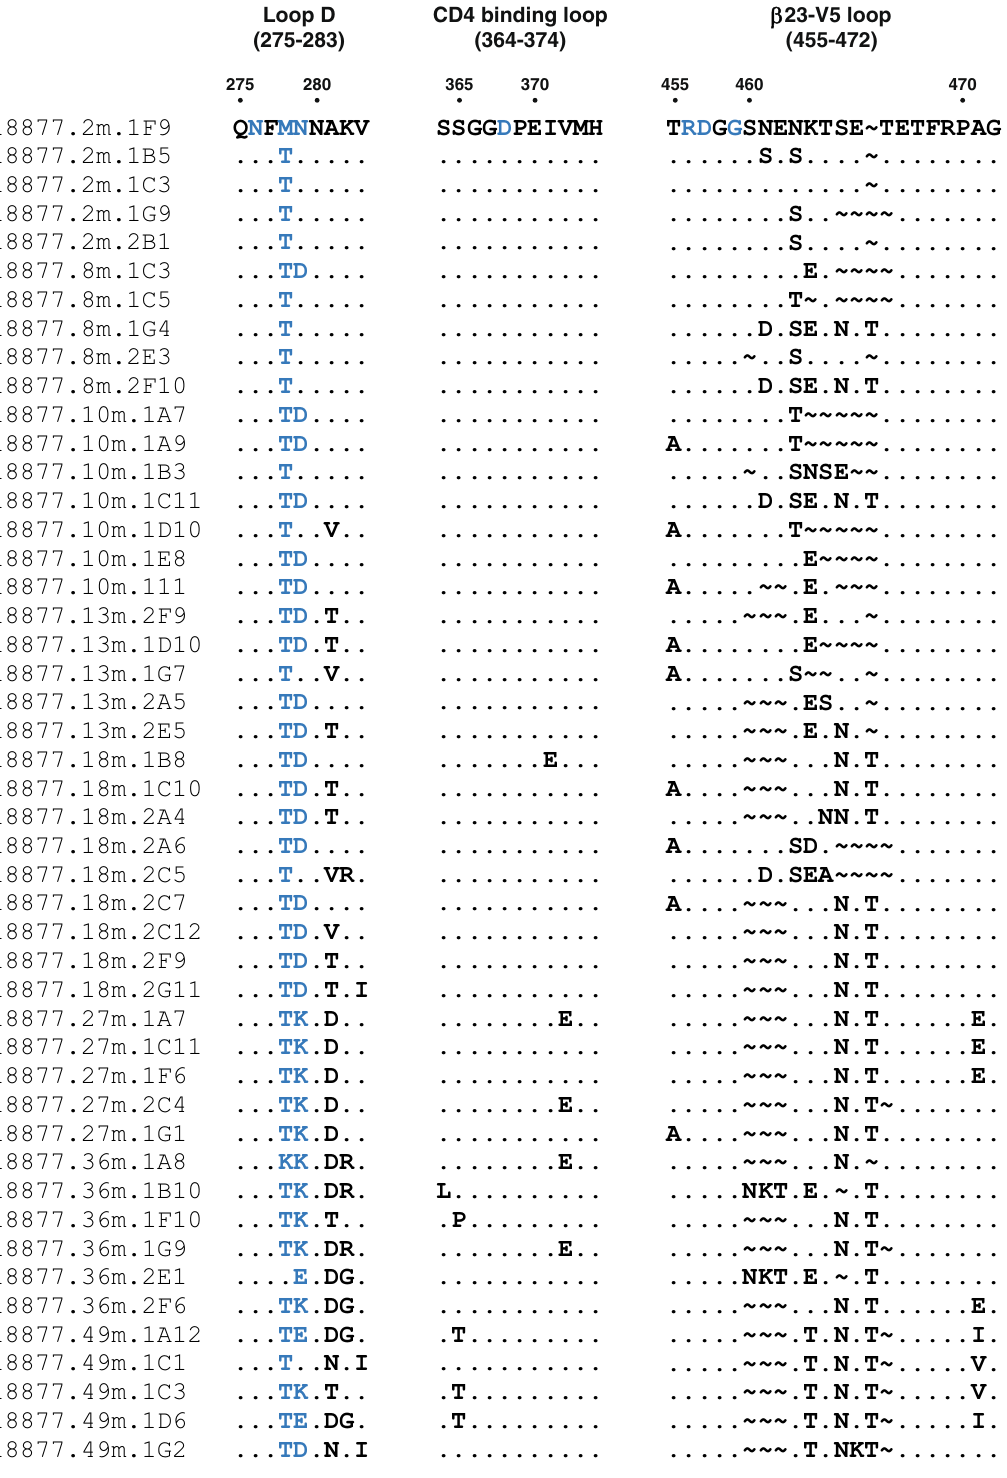
env sequence are named as followed; donor_name.month.clone,